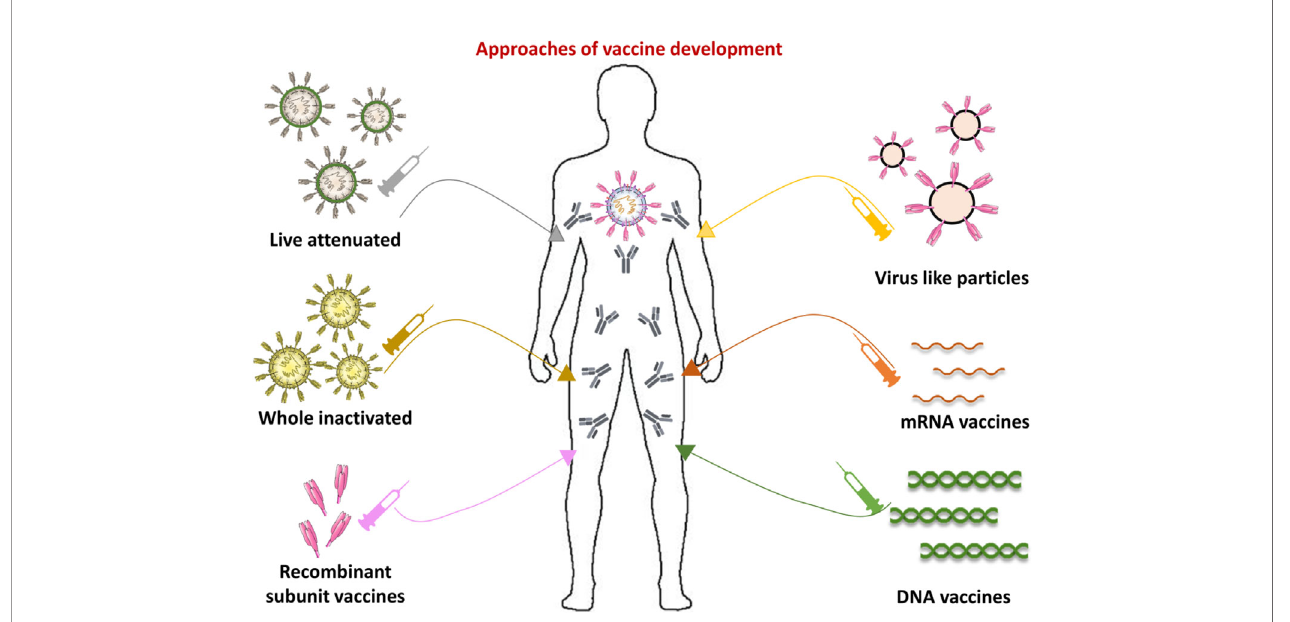
FIGURE 8 | Approaches of vaccine development. Current anti-viral vaccine strategies can be divided into those that resemble the virus and molecular-based or targeted vaccines. The vaccines based on attenuated or inactivated virus, and virus like particles (VLPs) keep viral structures, and or main components, whereas molecular targeted vaccines are composed on recombinant subunit proteins, and/or nucleic acids, such as DNA or RNA. A complete list of vaccines in development for each platform can be found at